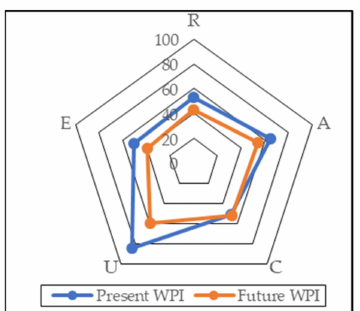
Figure 9. Present and future WPI pentagrams for female industrial workers in the Dhalla